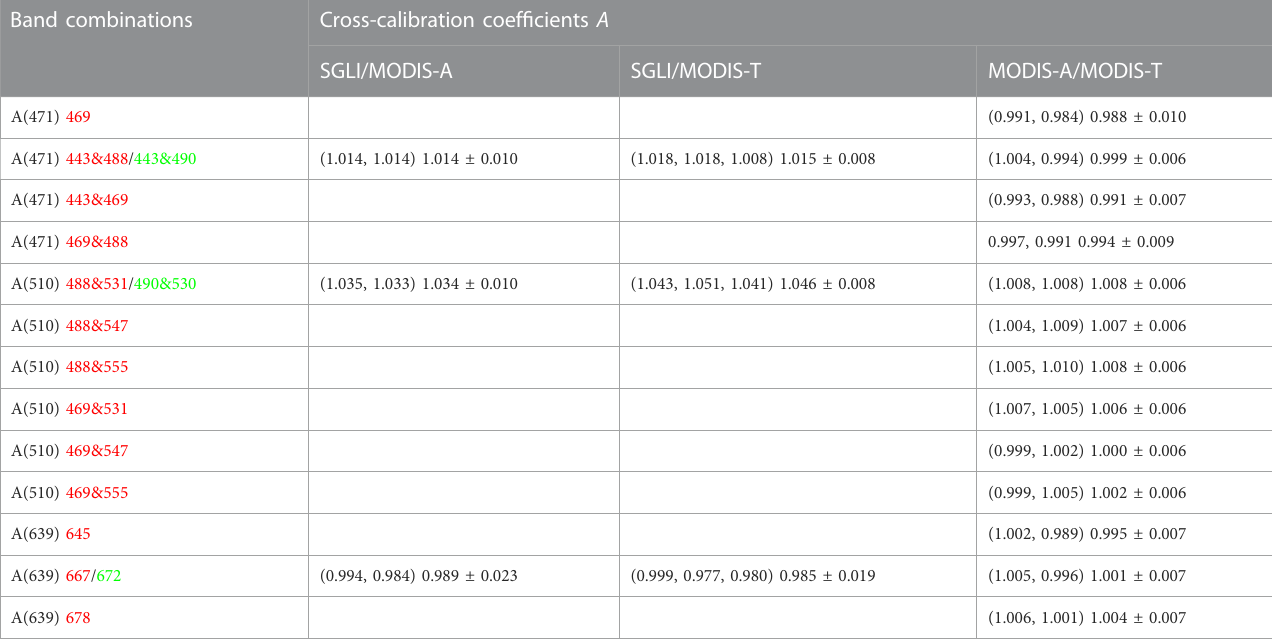
TABLE 8 The best estimate of cross-calibration coef fi cients A and associated uncertainties for SGLI/MODIS-A, SGLI/MODIS-T, and MODIS-A/MODIS-T, obtained using MODIS(redfonts)andSGLI(greenfonts)bandcombinations.Thecross-calibrationcoef fi cientsobtainedforindividualdaysarelistedinparentheses.Seethemaintext for more details on how to get the best